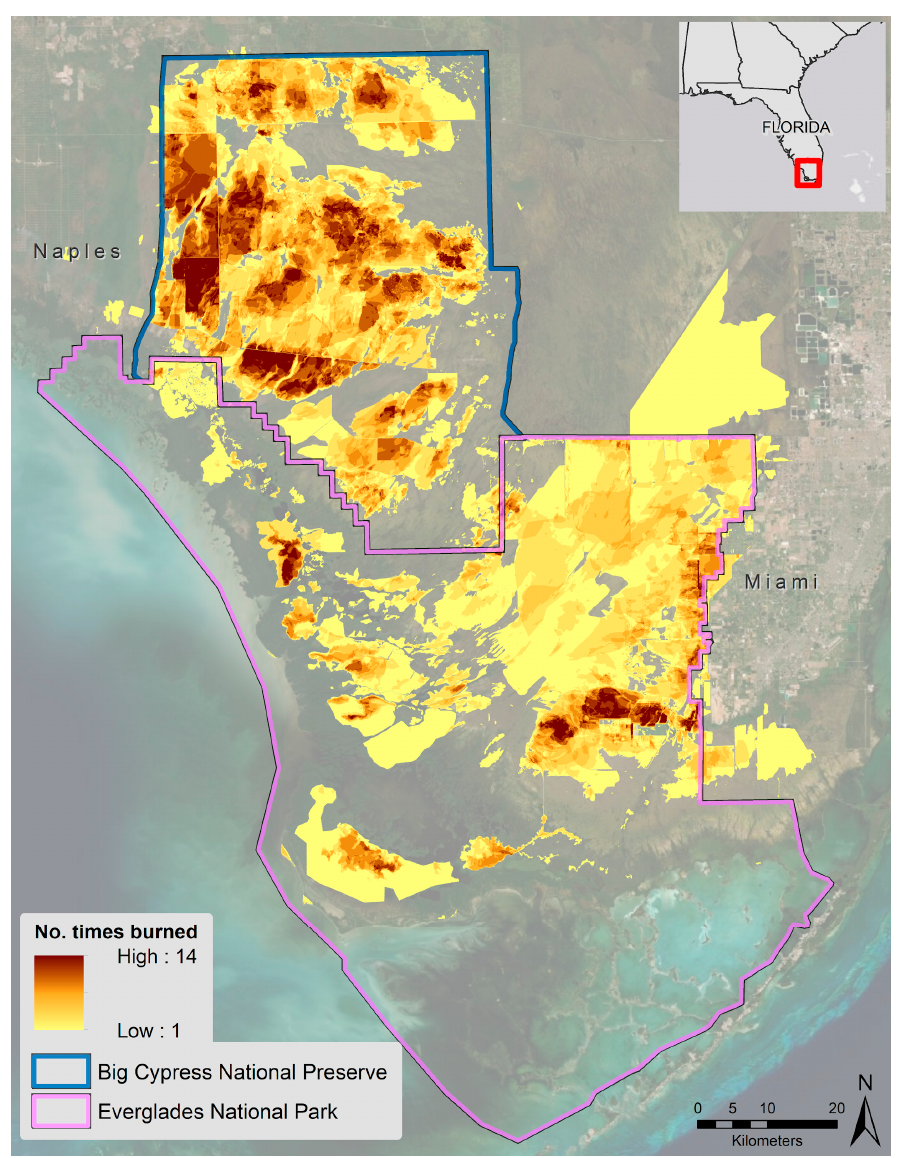
Figure 2. Big Cypress National Preserve and Everglades National Park experience frequent, low intensity wildfires that burn prairie grasses and pine forests in remote backcountry and near populated wildland-urban interface. Map portrays the number of prescribed fires and wildfires since 1980.